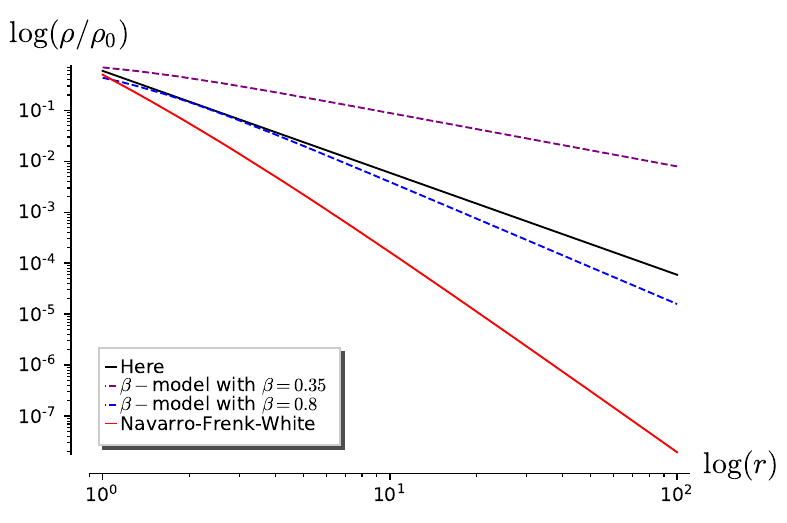
Figure 2. A qualitative comparison between the model in use here (the isothermal sphere) and two alternative models often used to describe the distribution of matter in galactic